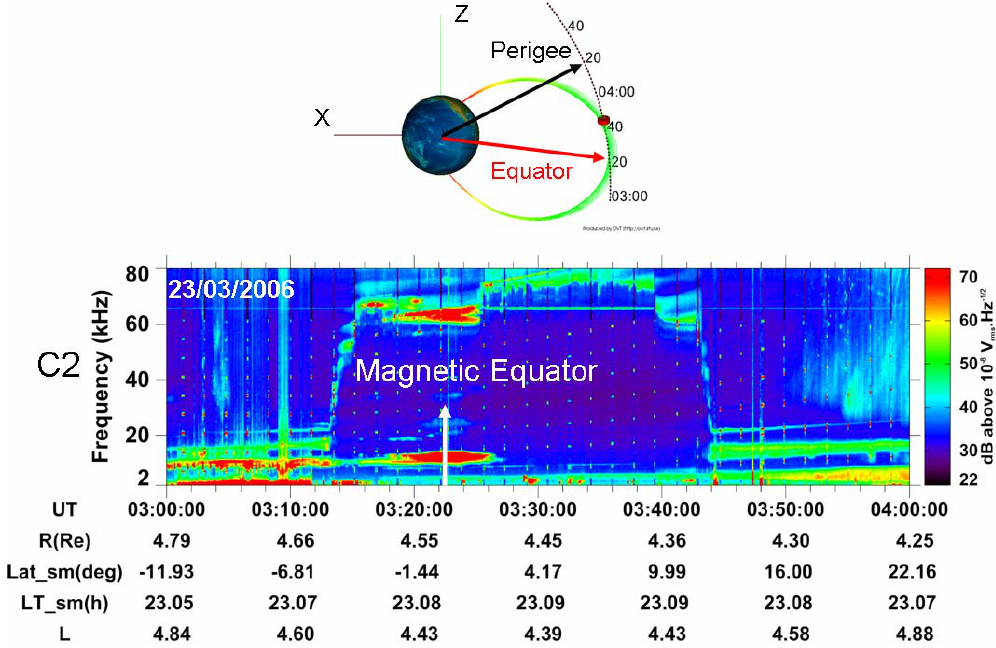
Figure 1. Plasmasphere crossing during intermediate CLUSTER mission phase. Bottom panel shows the spectrogram recorded by C2 during this interval. Top panel is a GSM view of the C2 satellite trajectory, from minus Y, produced by the OVT tool (http://ovt.irfu.se). Both panels point out the magnetic equator, encountered inbound, about one hour before perigee. The C2 satellite grazes a plasmasphere boundary layer at L ~4.5, near midnight local time.